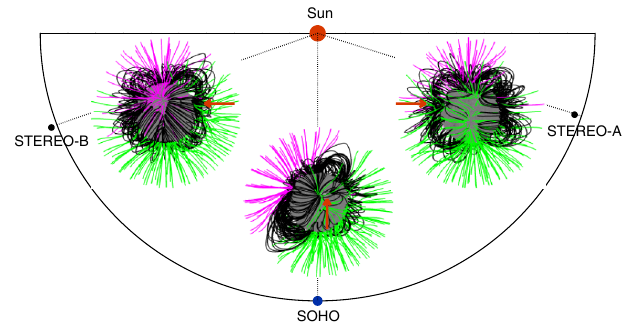
FIG. 1. Blob event 3 as observed from the three spacecraft STEREO-B, SOHO and STEREO-A, respectively. The CME preceding the merging of the two blobs occurred on 23 May 2010, and the blobs were observed on 24 May 2010. The longitudinal separation between the STEREO-A (STEREO-B) spacecraft and the SOHO spacecraft is 71.62 (cid:3) (69.97 (cid:3) ). A halo CME that erupted from a diffuse bipolar structure at 18:06 on 23 May was observed by the LASCO instrument on SOHO. The CME was also observed in both STEREO-A and STEREO-B spacecraft. The magnetic-field configurations obtained by the PFSS model [36] as seen from STEREO-A, SOHO, and STEREO-B are also shown in the figure. The red arrows indicate the location of the diffuse bipolar structure from which the CME erupted. To the north of the CME is a nearby streamer (shown as closed field lines in black).